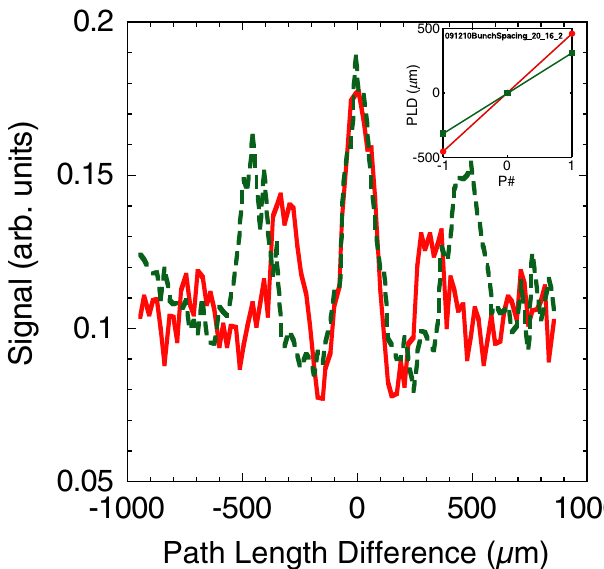
FIG. 13. (Color) Autocorrelation traces obtained with two drive bunches (red continuous line) of Fig. 12, and with the last drive bunch and the witness bunch (green dashed line). The measured interferometer path length difference for each train shows that the spacings are (cid:1) z 0 ffi 458 (cid:8) m and (cid:1) z ffi 313 (cid:8) m , respectively (see inset).